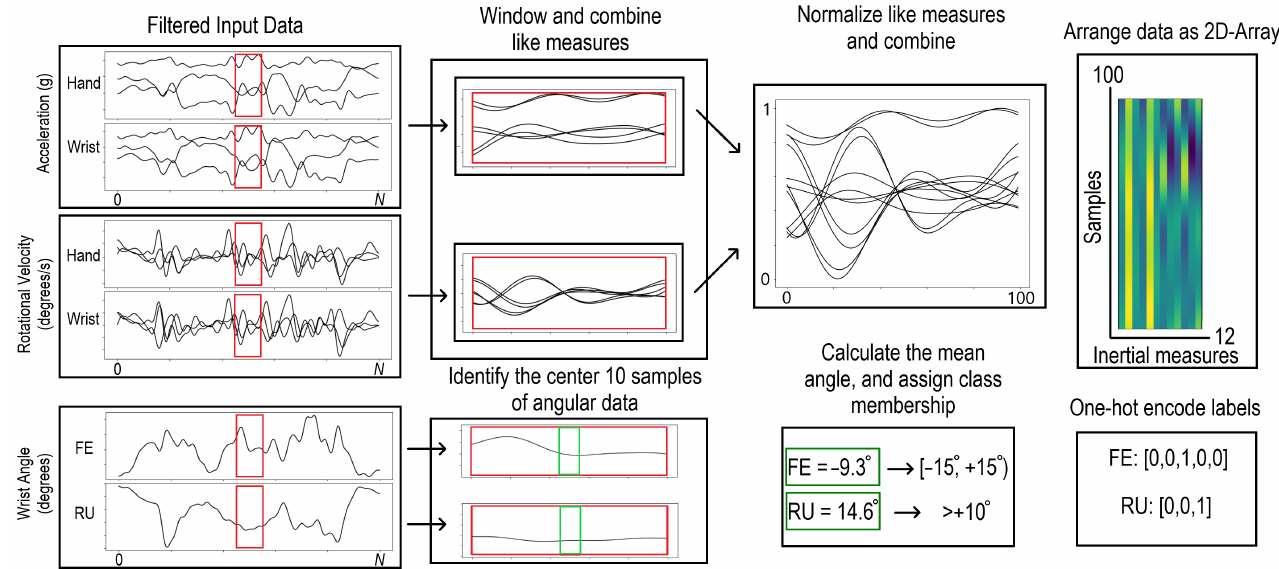
Figure 5. Data preprocessing for network